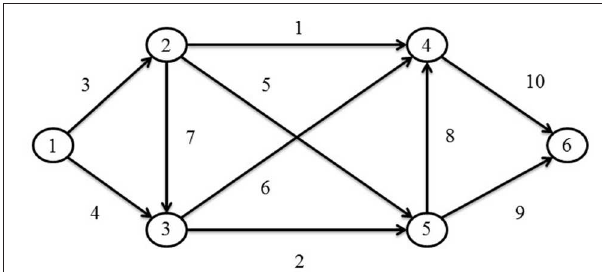
FIGURE 1 | The network.